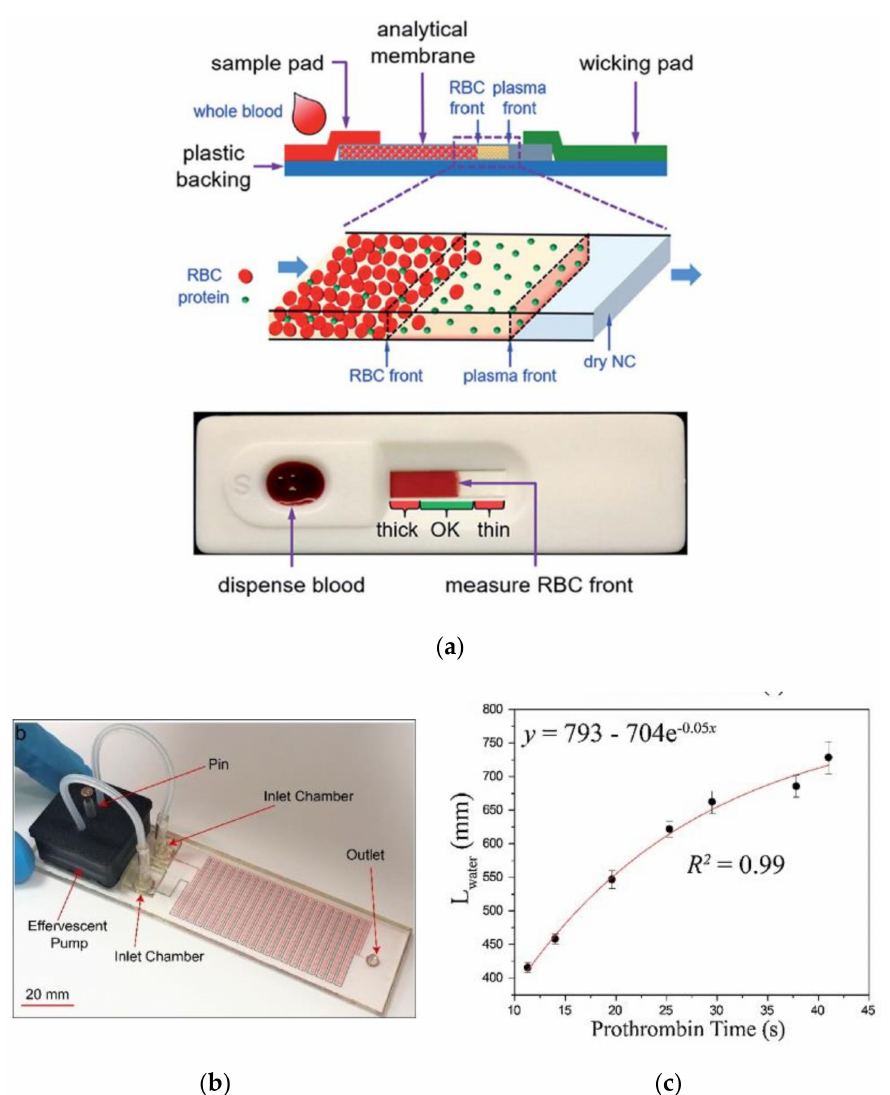
Figure 12. ( a ) Schematic illustration and photograph of the paper-based lateral flow assay (LFA) for coagulation time measurements engineered by Li et al. in 2018. (Reprinted with permission from ref. [92]. Copyright 2018 Royal Society of Chemistry.) ( b ) Photograph of the PT measurement device engineered by Guler et al. in 2018. ( c ) Correlation plot for conventional PT measurement versus water travel distance. (Reprinted with permission from ref. [32]. Copyright 2018 Elsevier